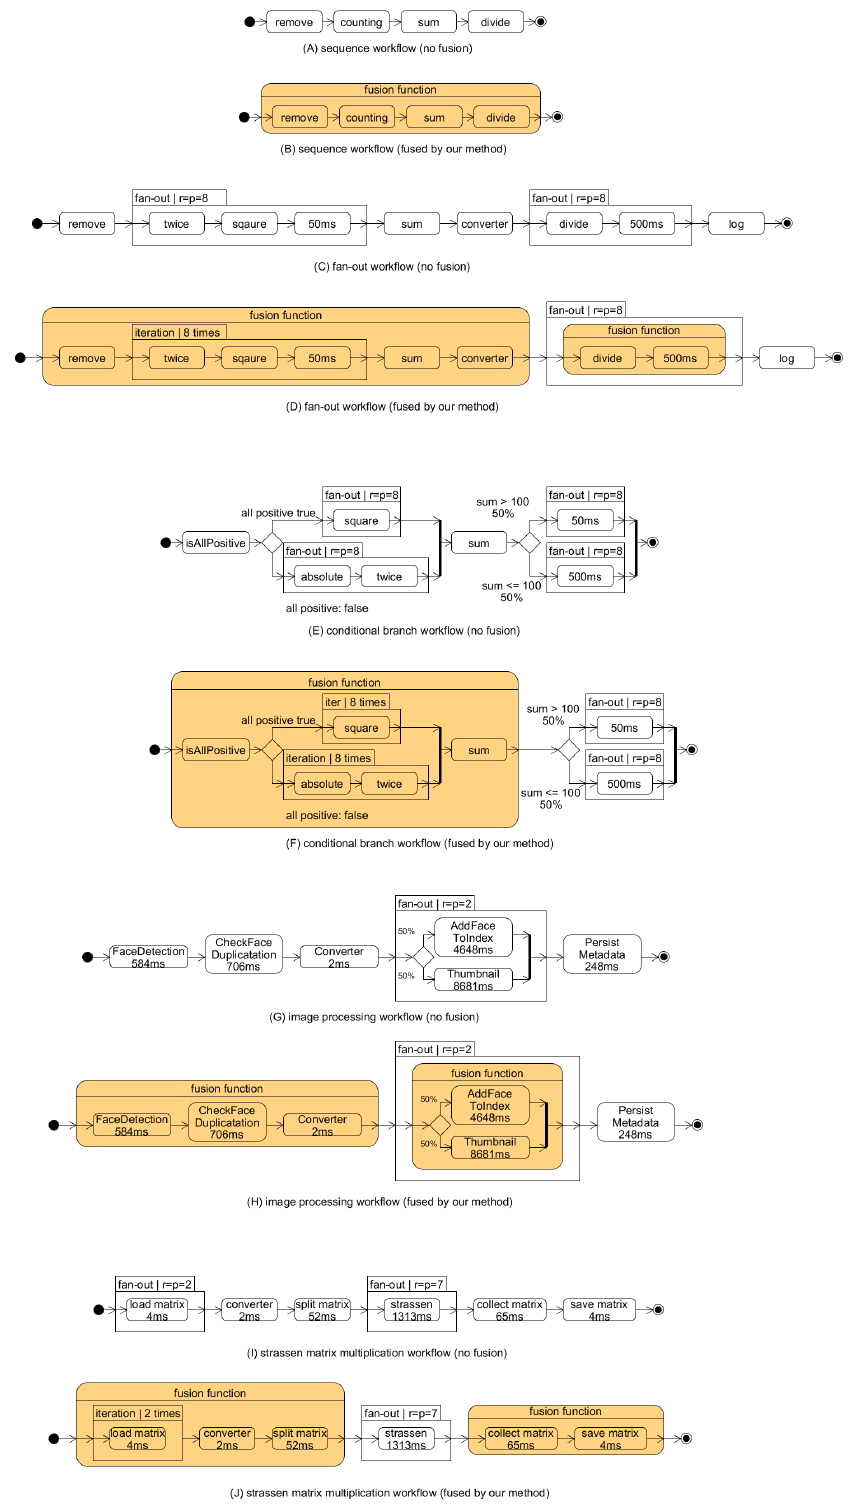
Figure 9. Three workflows to show that different decisions take place in some cases and two workflows that have a purpose for real-world scenario. ( A , C , E , G , I ) are original workflows that are not fused, ( B , D , F , H , J ) are workflows fused by our